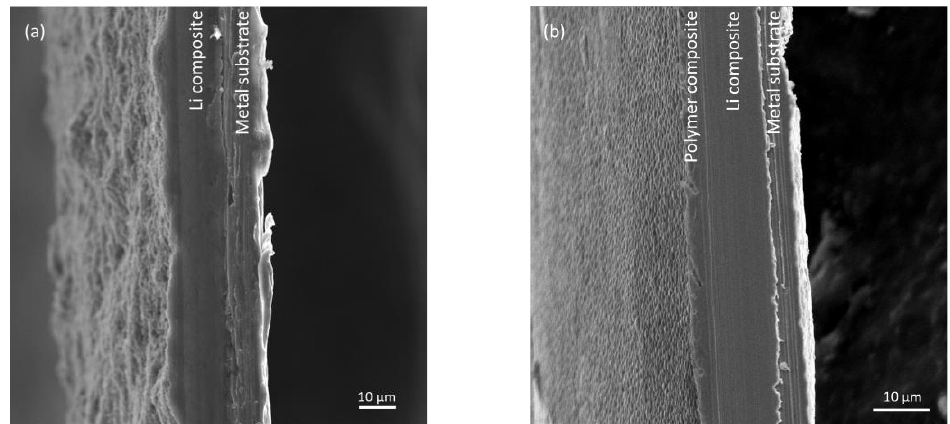
Figure 2. Cross sectional SEM images of anodes: ( a ) Pristine pre-lithiated graphite and carbon black